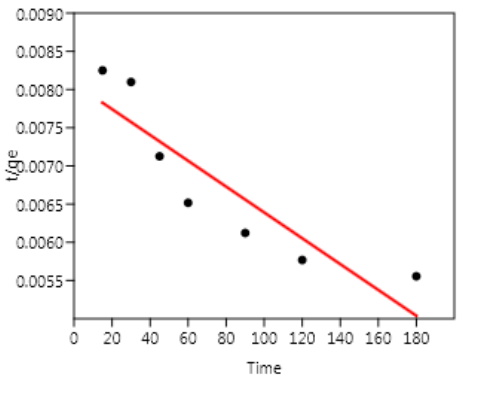
Figure 10. The Pseudo-first-order kinetics of the adsorption of nitrite by chitosan-activated carbon nanocomposite